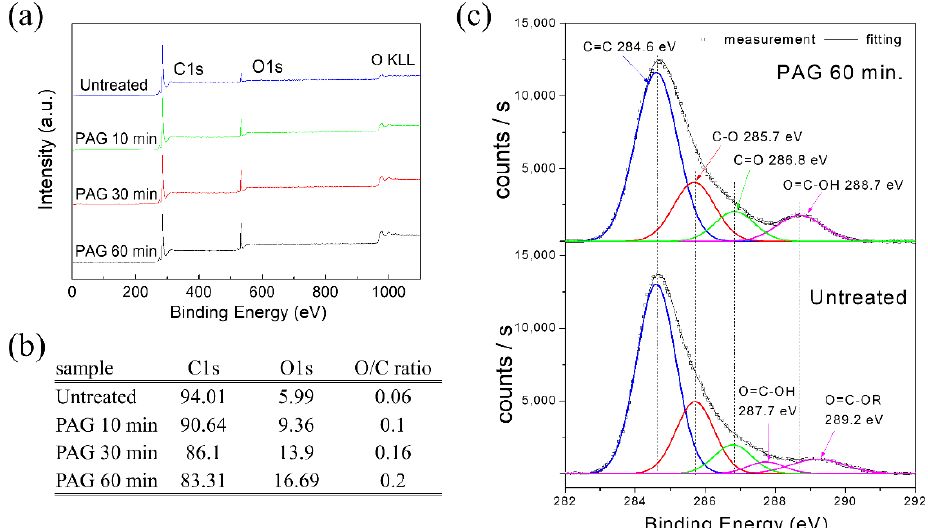
Figure 7. Results of X-ray Photoelectron Spectroscopy (XPS) spectra analysis: ( a ) Full survey spec- trum, ( b ) O/C ratio, and ( c ) high-resolution element carbon (C 1s) spectrum on the PAG-treated 60 min sample.